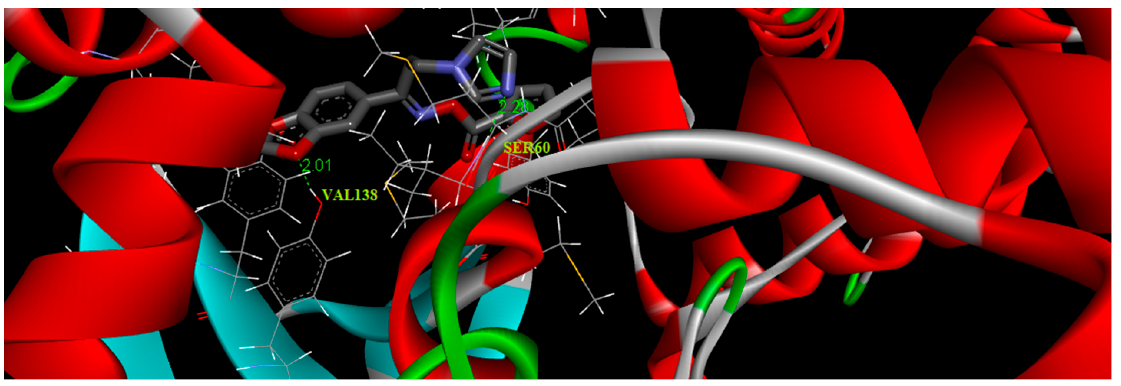
Figure 6. Binding pose diagram of the oximino ester 5 with its target protein.